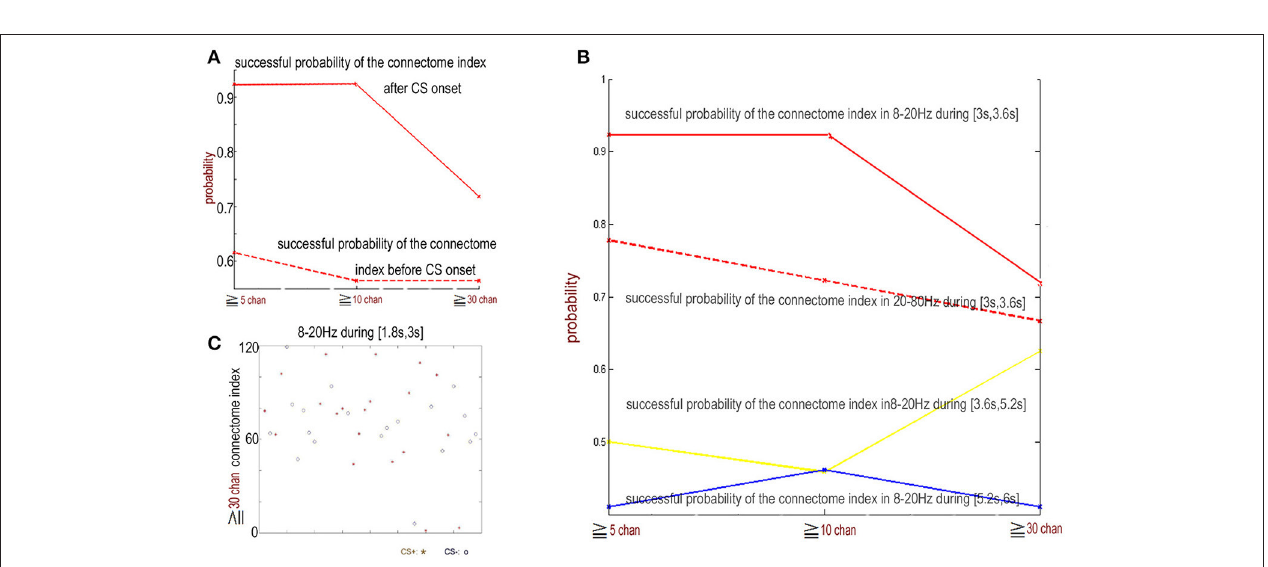
FIGURE 5 | Normalized connection matrix of connectome in 8–20Hz band from 3 to 3.6s (just after CS onset) across more than 5 channels. (A) CS trails. There are clearly strong connections from channel 17 to channel 20, channel 25 to channel 27, channel 33 to channel 38, and channel 41 to channel 45 in CS trails ( p 5 10 − 7 , α 0.05 t -test). (C) The association causes strong local conneting activities across channel 17 to channel 20, channel 25 to channel 27, channel = × = 33 to channel 38, and channel 41 to channel 45 in CS trails (active channels/total channels < 28%). +